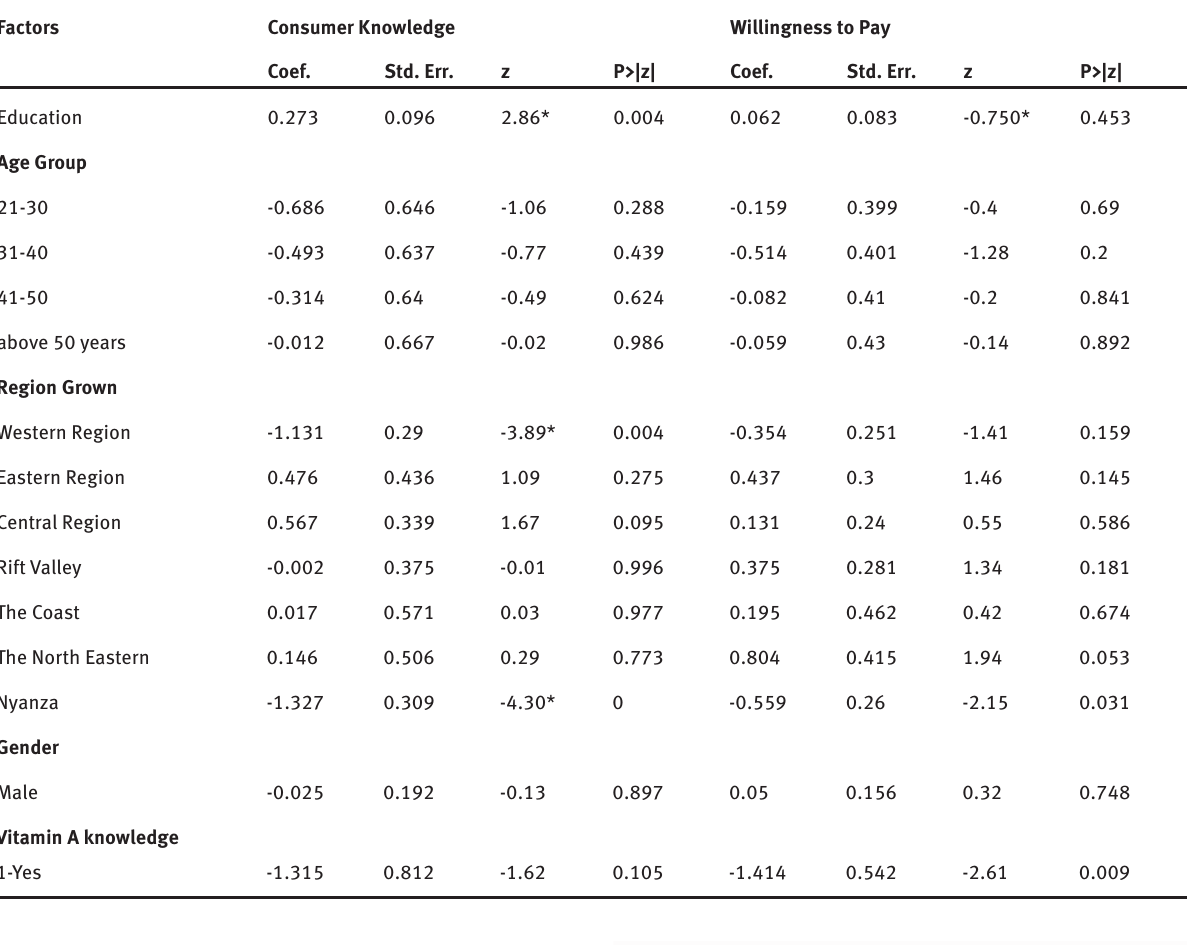
Factors Consumer Knowledge